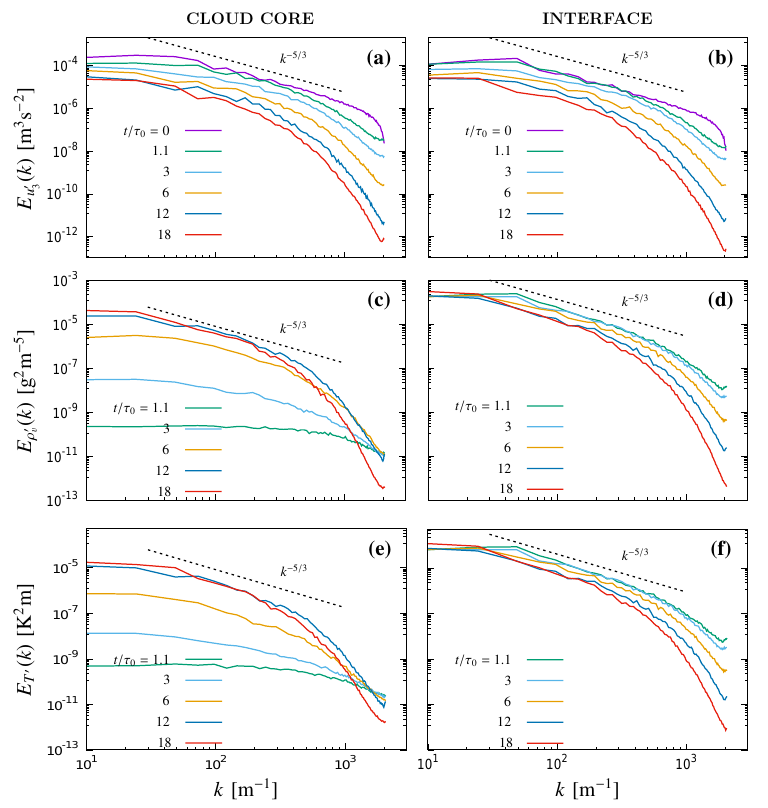
Figure 5. Transient evolution of one dimensional horizontal spectra: ( a , b ) transversal spectra of u (cid:48) ( c , d ) spectra of water vapour fluctuations ρ (cid:48) v ; and ( e , f ) temperature fluctuations T (cid:48) respectively at cloud core and at the